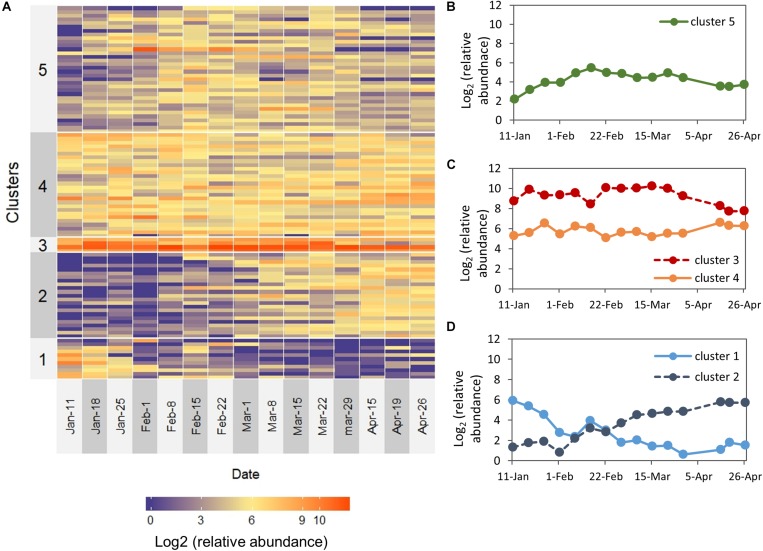
Temporal patterns for the 100 most abundant OTUs over the study period. (A) The heat map depicts the log2 (relative abundance) for each OTU. OTUs are ordered based on K-means clustered into five groups (left labels). (B–D) Plots of the temporal dynamics of clusters (centroids) that were visually assigned to: (B) OTUs found at intermediate abundance in the middle of the study period, (C) high abundance and intermediate abundance throughout the entire study period (D) descending abundance and ascending abundance.